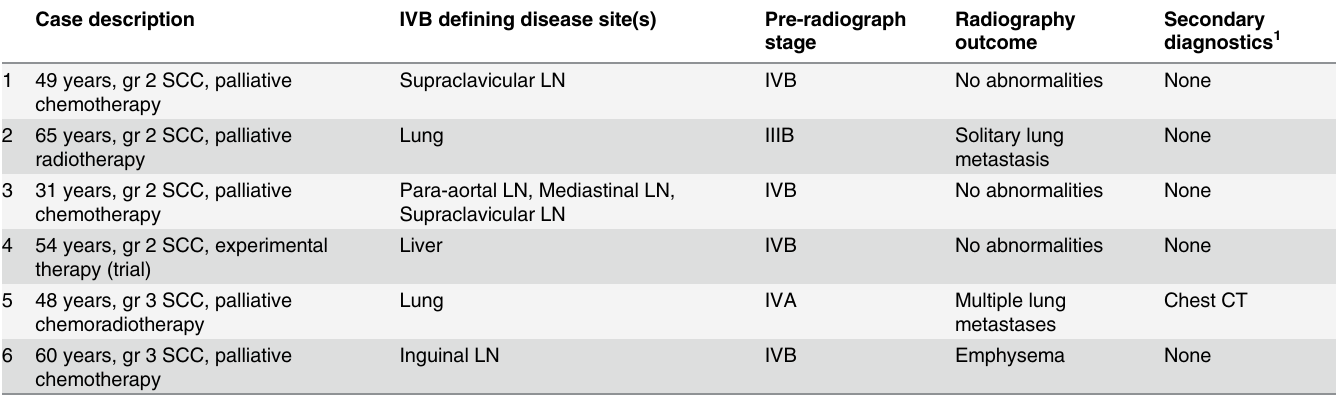
Table 2. Outline of FIGO stage IVB cervical cancer cases in the study